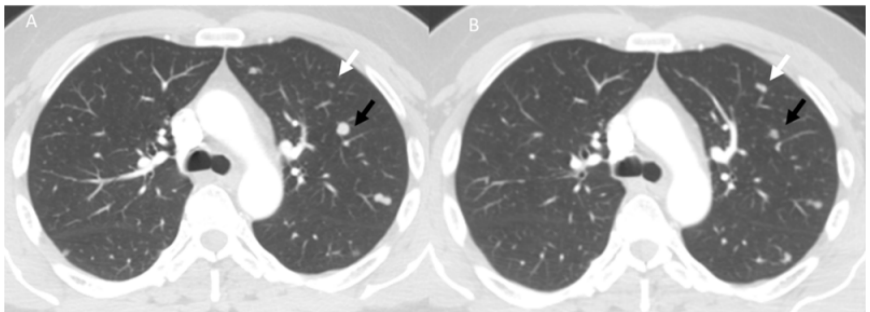
Figure 6. Dissociated responses in a melanoma patient during immunotherapy. CT assessment in pre-treatment phase ( A ) and at 3 months ( B ) follow-up: black arrows show the regression of the lesion while white arrows show the increase in lesion dimensions.